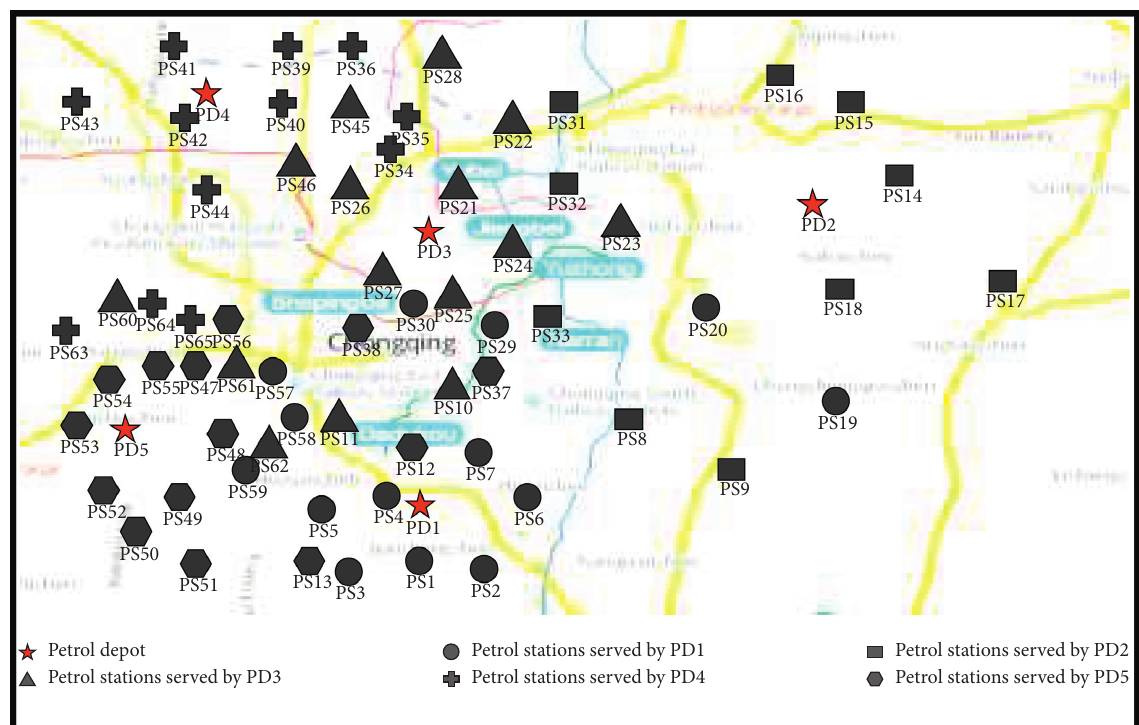
Figure 4: Petrol depots’ and petrol stations’ distribution diagram.